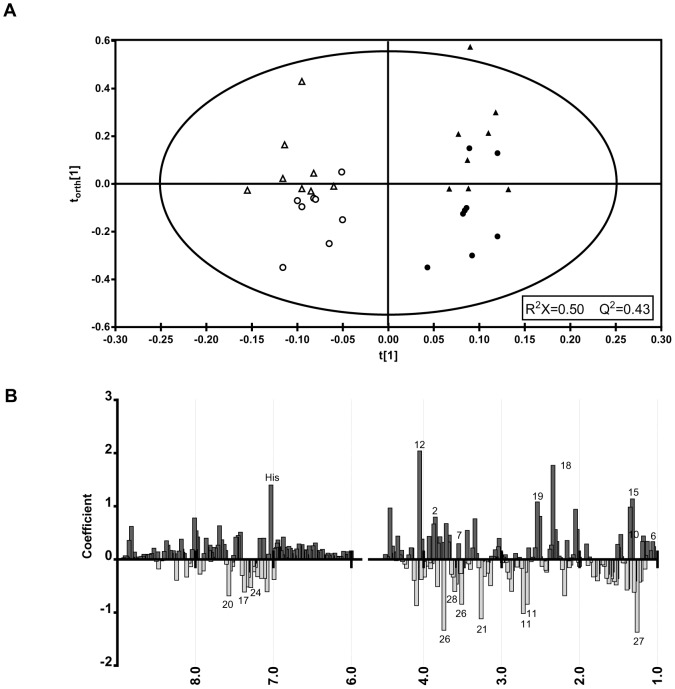
Statistical analysis of 1H NMR spectra.(A) OPLS-DA component plot derived from spectra of urine before (▴, athlete and •, control) and after execise (Δ, athlete and ○, control). R2X = 0.50; Q2 = 0.43. (B) OPLS coefficient plot showing the most significant contributors to the separation. Numbered biomolecules correspond to Table 3.